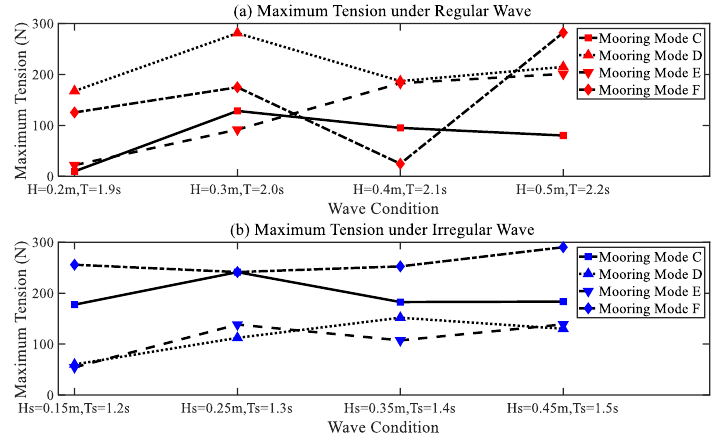
Figure 9. The maximum tension on the anchor line of the two-anchor line mooring mode.